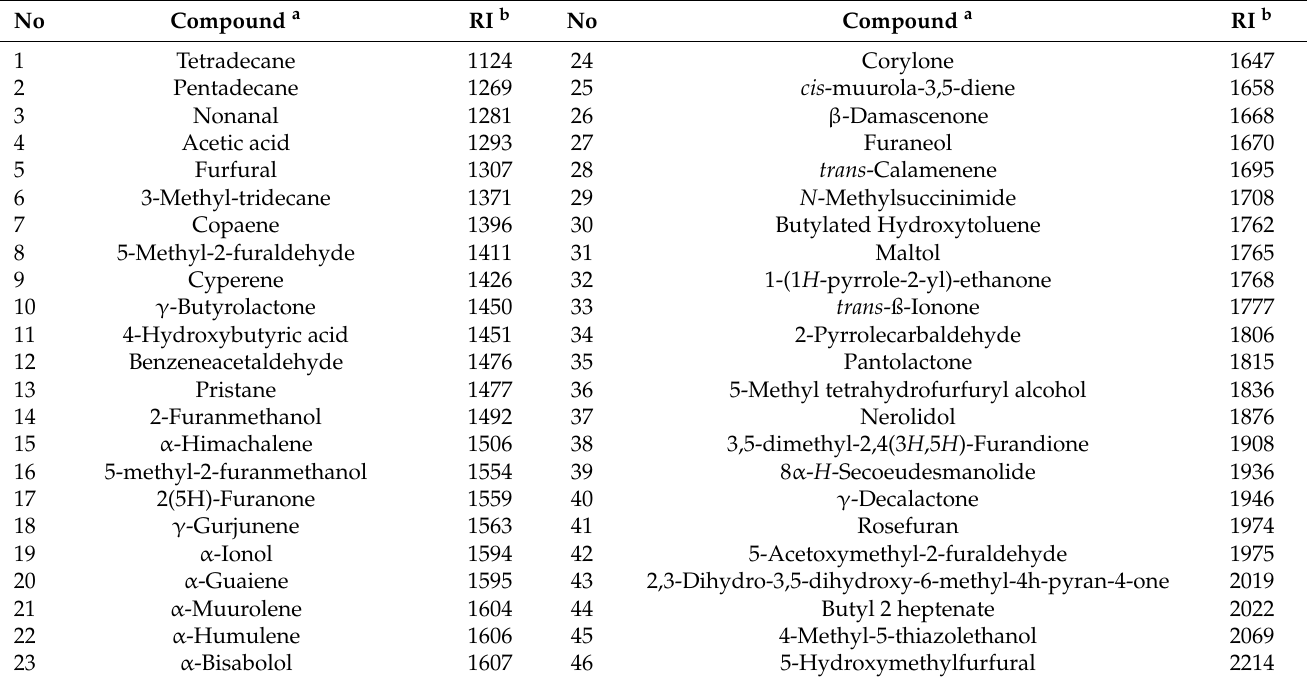
Table 3. Volatile compounds of sweet potatoes identified during roasting